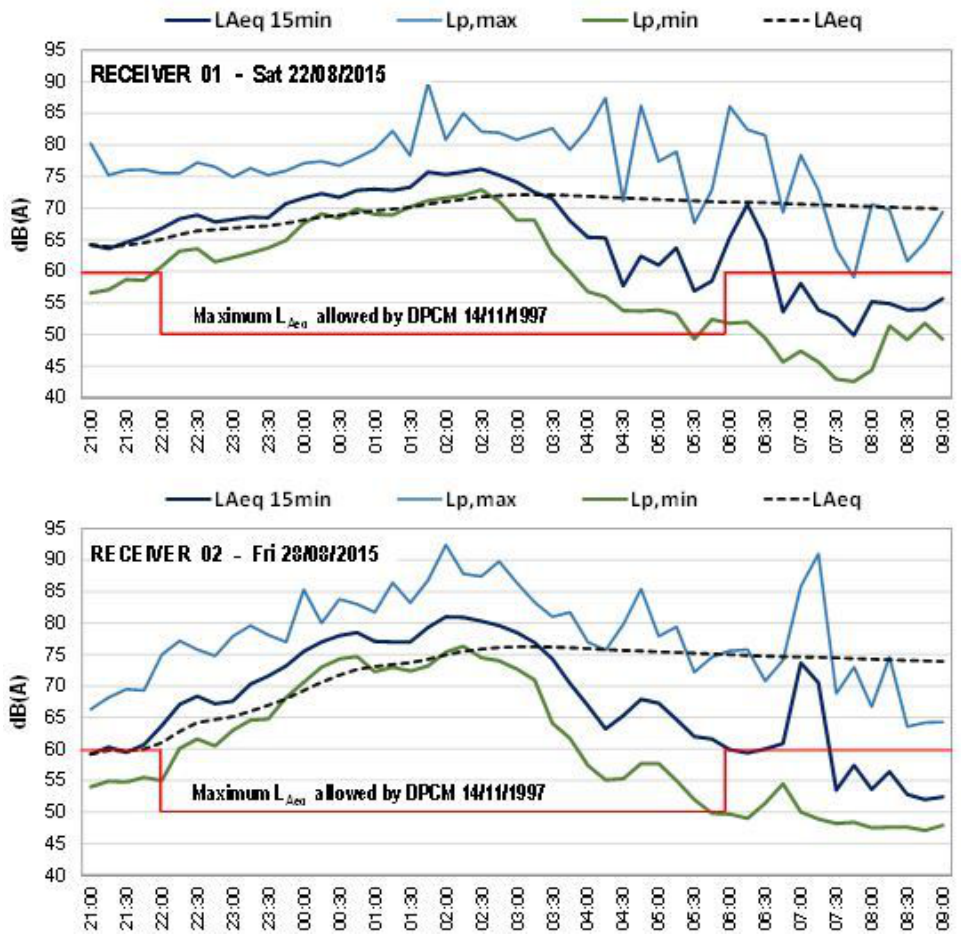
Figure 8: Results of the noise measurement campaign for Receiver 01 and Receiver 02